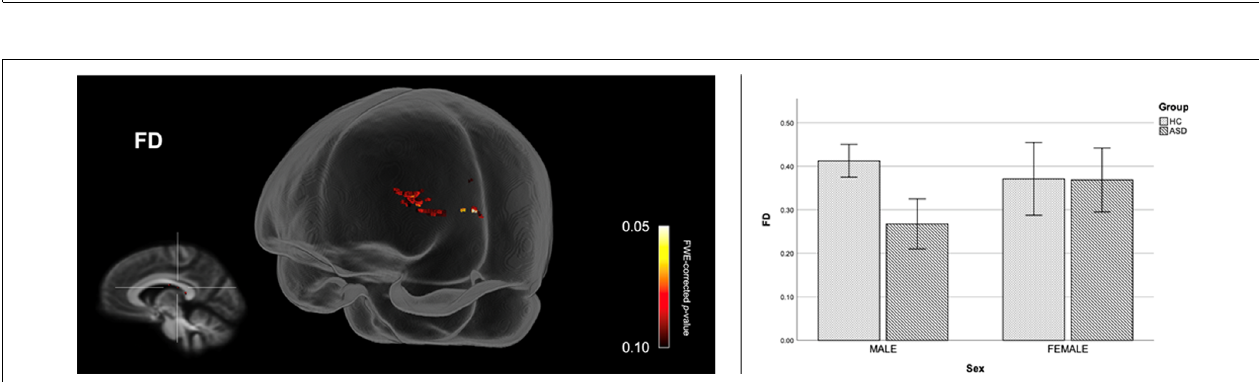
FIGURE 3 | Fiber specific tract reductions in fiber-bundle cross-section (FC) in females with ASD (compared to females in the control group). Streamline segments were cropped from the whole brain tractogram to include only streamlines that traversed fixels showing a trend towards reduced FC in females with ASD ( p < 0.10, FWE corrected). FWE = Family-wise error. Bar graphs represent mean fiber-bundle cross-section in each group. Mean FC was computed for each participant across all fixels showing a trend towards reduced FC in females with ASD ( p < 0.10, FWE corrected). Error bars represent 95% confidence intervals. FWE = family-wise error; HC = healthy control.